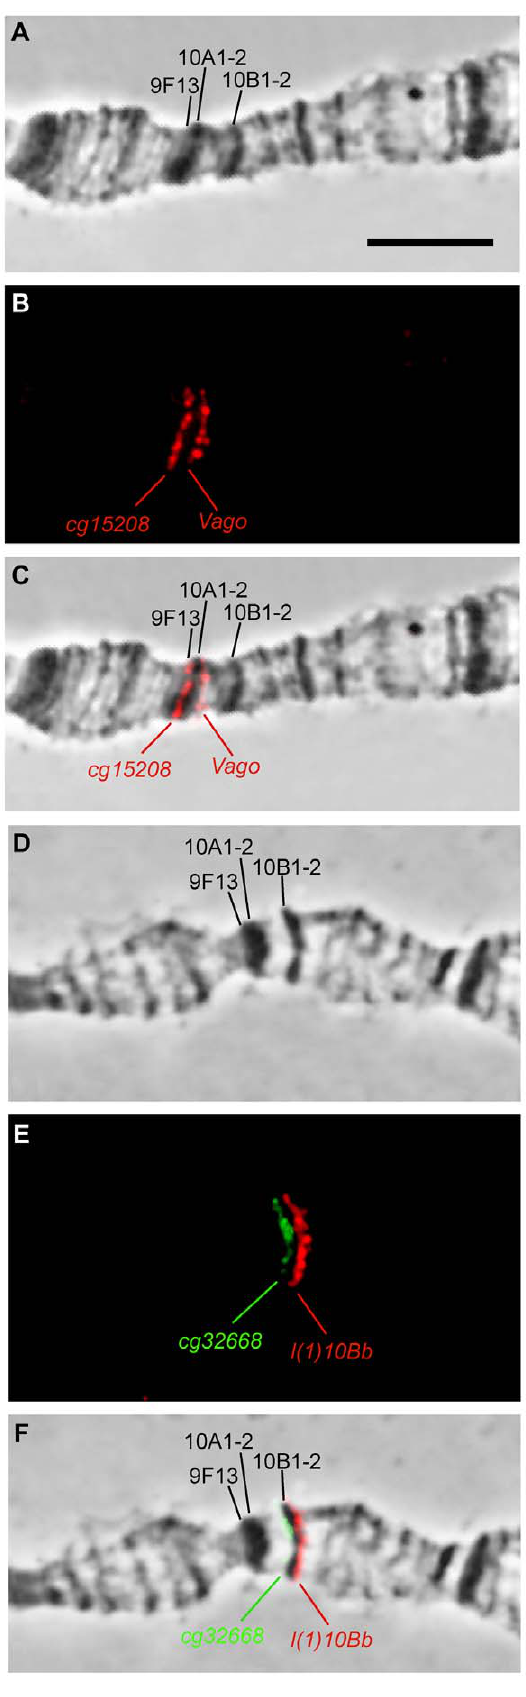
Figure 3. Localization in polytene chromosomes of DNA fragments, which according to modEncode data are located in the predicted interbands flanking the 10A1–2 and 10B1–2 bands of the nonpolytene chromosomes. Banding pattern in the region under phase contrast microscope ( A, D ), pairwise FISH mapping of DNA fragments, limiting the bands 10A1–2 (probes CG15208 and Vago) ( B, C ) and 10B1–2 (CG32668 and l(1)10Bb) ( E, F